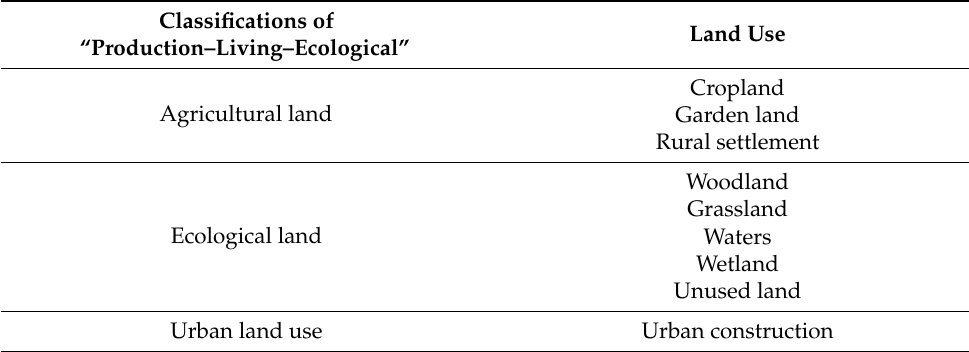
Table 3. Classification system of three types of land.